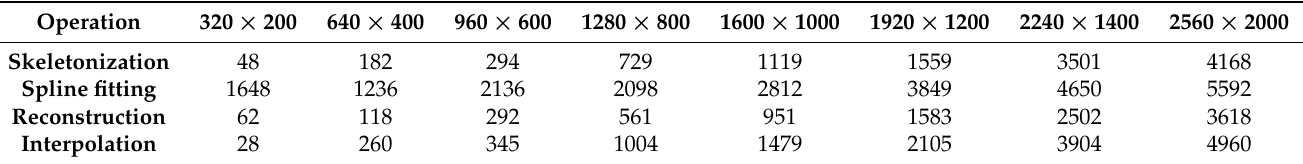
Table 3. Running time of four SDMD steps on images of different resolutions, in